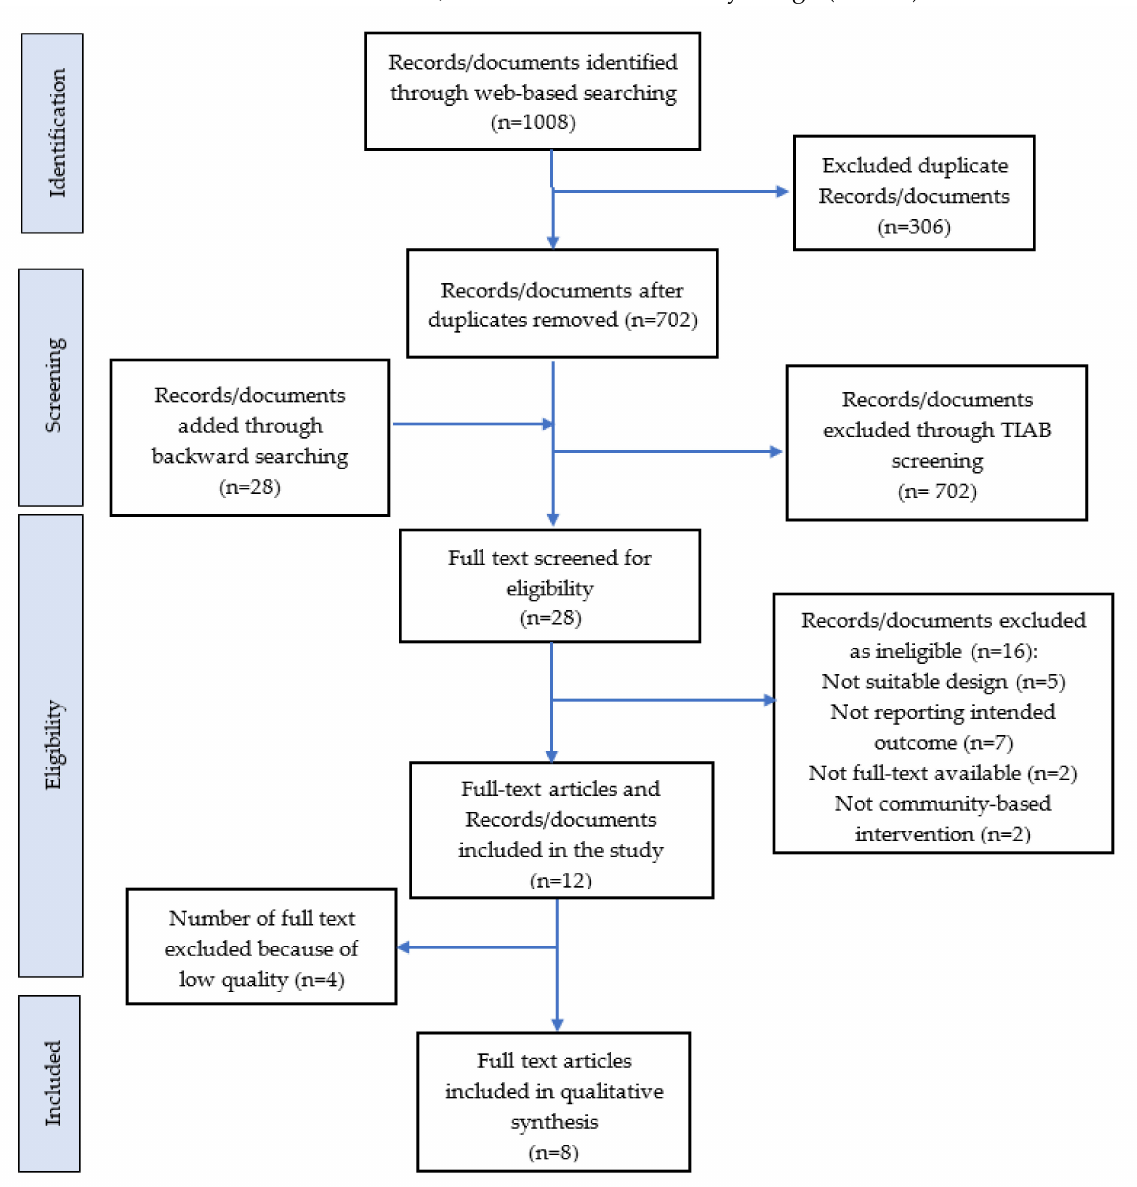
Figure 1. PRISMA diagram of information flow through phases of the systematic review. Low quality was the reason for further exclusion of four articles (Table 2). Finally, eight articles remained that met the inclusion criteria for the systematic review (Table